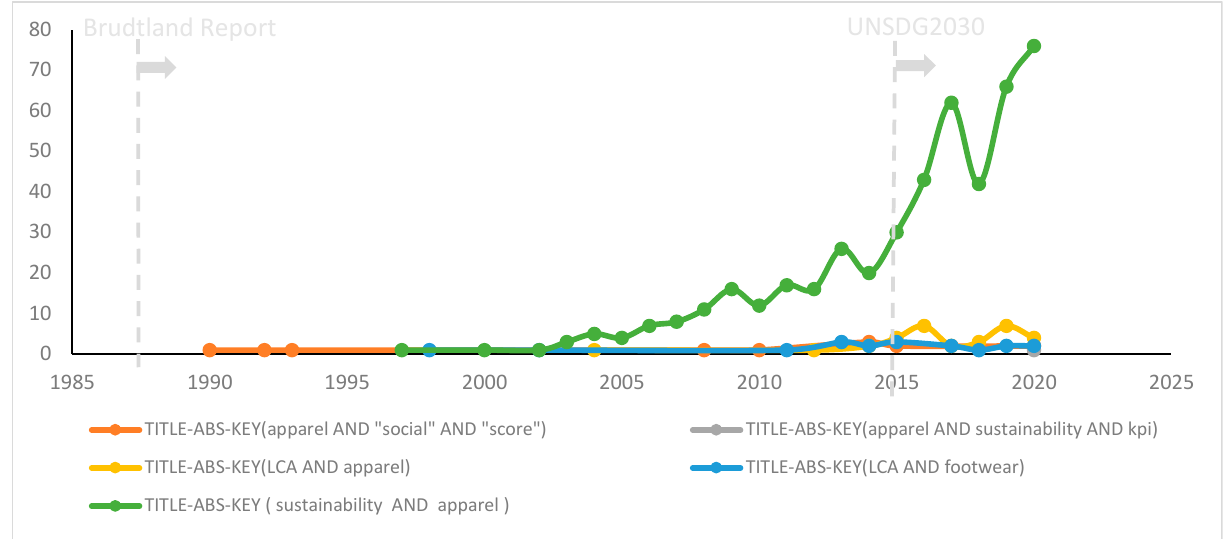
Figure 2. Supply chain of fashion products and life cycle steps. Logistics and reverse logistics create air emissions due to tire abrasion on roads or hydrocarbon fuel combustion in maritime, air, and road transportation.